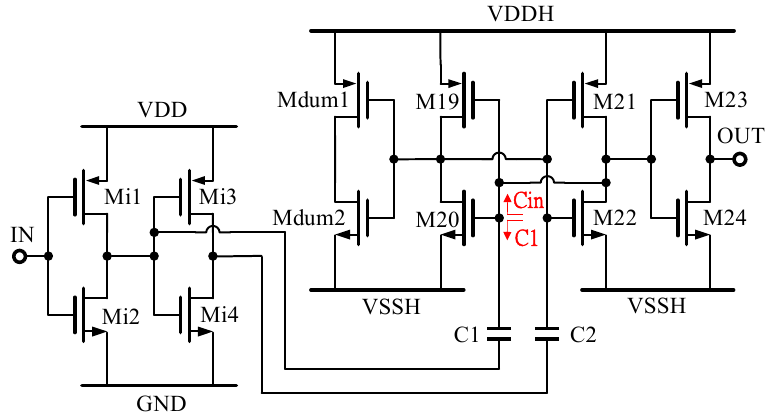
10 of 22 Figure 10. Schematic of a latch-based full-swing level-shifter.